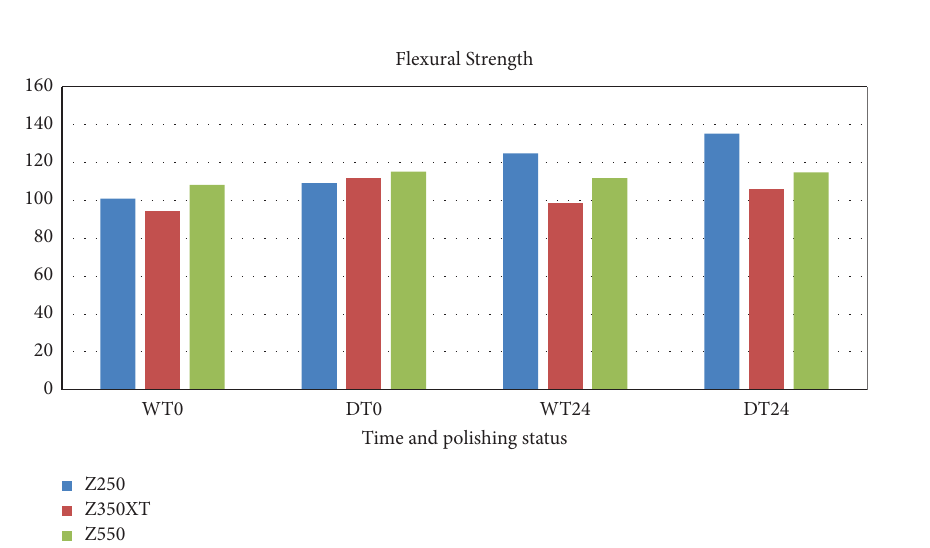
0 ) and 24hours ( T 24 ) after dry D and wet W